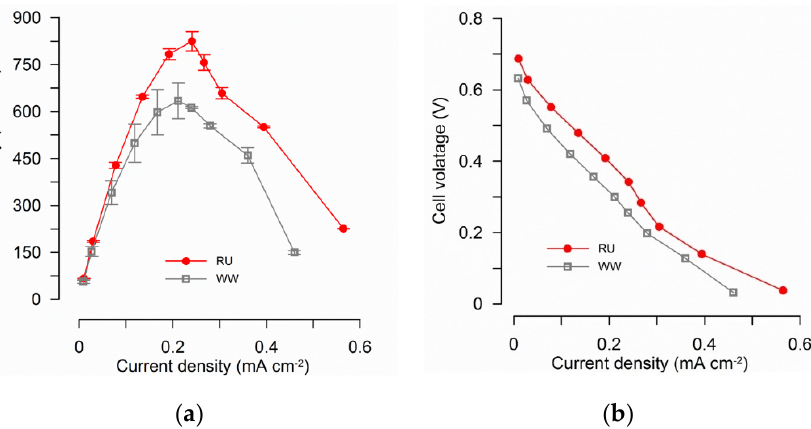
Figure 2. Polarization results for two batch cycles in duplicate reactors for each condition (during the test, external resistance was changed from 10 Ω to 40 kΩ). ( a ) Rumen reactors showed higher power production than other conditions. ( b ) Polarization curves for the two tested conditions showed a reduction in activation losses for rumen reactors, observed by a decrease in the slope at low current densities. RU: rumen plus wastewater; WW: wastewater.